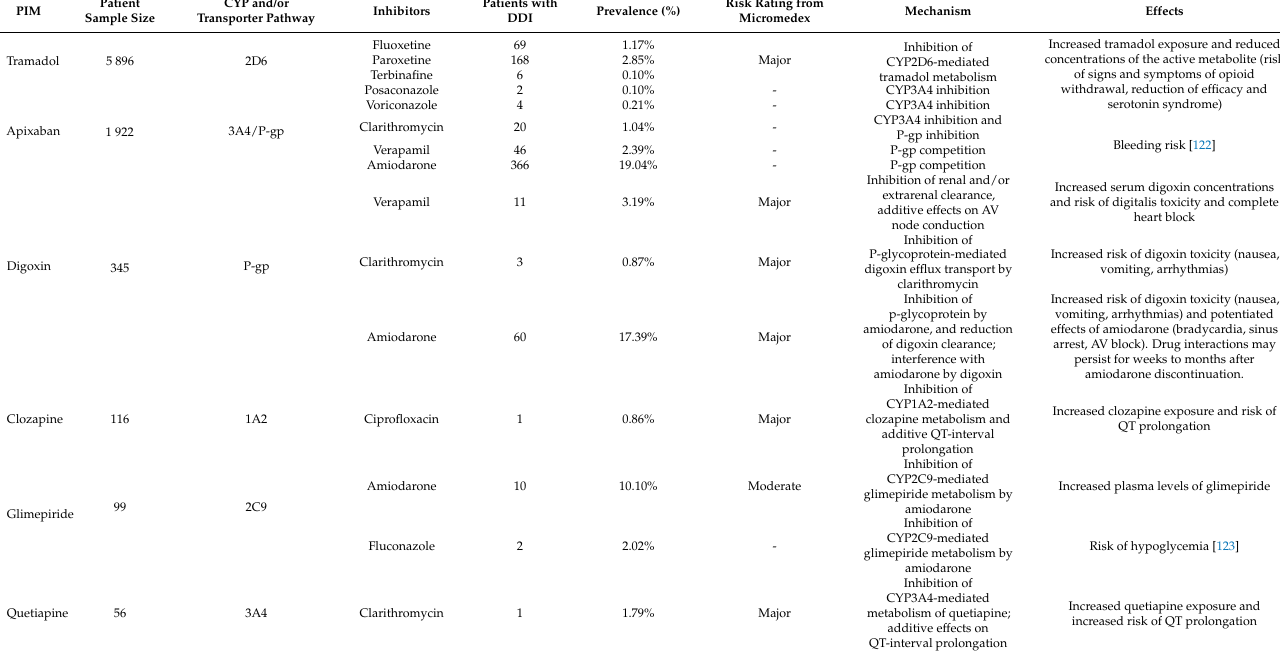
Table 5. Prevalence of DDI of moderate or major intensity (by inhibition of a metabolic or of a transport pathway) regarding six selected PIM in hospitalized patients. Data were extracted from the clinical data warehouse of Rennes University Hospital (eHop). DDI were checked by using Micromedex and literature search in Pubmed. Specific bibliographic references were added when DDI was not indexed in Micromedex. Footnote: not indexed